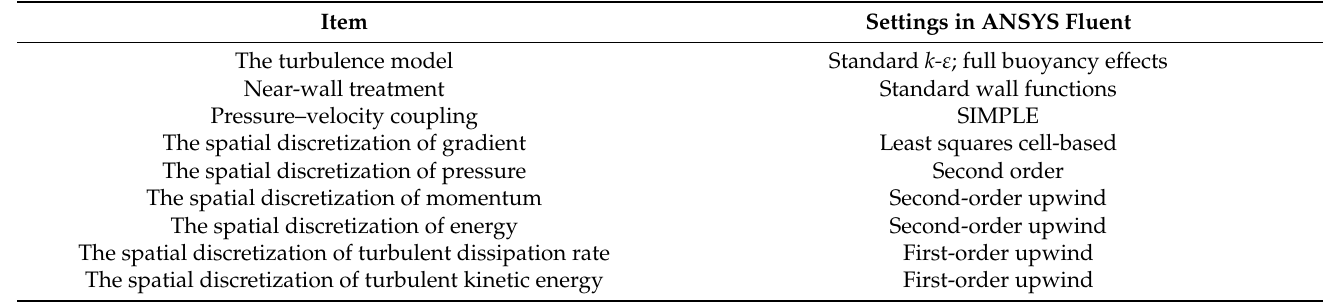
Table 1. Model and discrete scheme